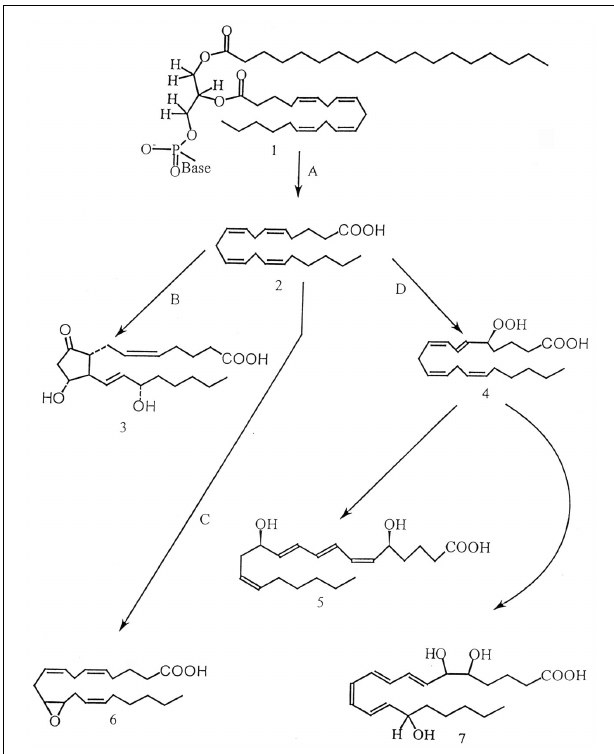
FIGURE 1 | Eicosanoids are synthesized by oxygenation of polyunsaturated fatty acids, mainly from arachidonic acid (AA; 20:4 n − 6). AA (structure 2) is liberated from the membrane phospholipids (structure 1) via activation of phospholipase A 2 (enzyme A).The free fatty acids are subsequently metabolized via three different pathways: (i)The cyclooxygenase pathway (enzyme B), forming prostaglandins, thromboxanes or prostacyclins, (ii) the various lipoxygenase pathways (enzyme D), forming leukotrienes, lipoxins, hepoxilins and hydro(pero)xy- and hydroxy-fatty acids and (iii) the cytochrome P-450 (cyt P-450) pathways (enzyme C), forming epoxy derivatives. Structure 3 is prostaglandin E 2 , structure 4 is 5-hydroperoxyeicosatetraenoic acid, structure 5 is leukotrienes B4, structure 6 is 11,12-epoxyeicosatrienoic acid and structure 7 is lipoxin A. (From Stanley, 2000 with